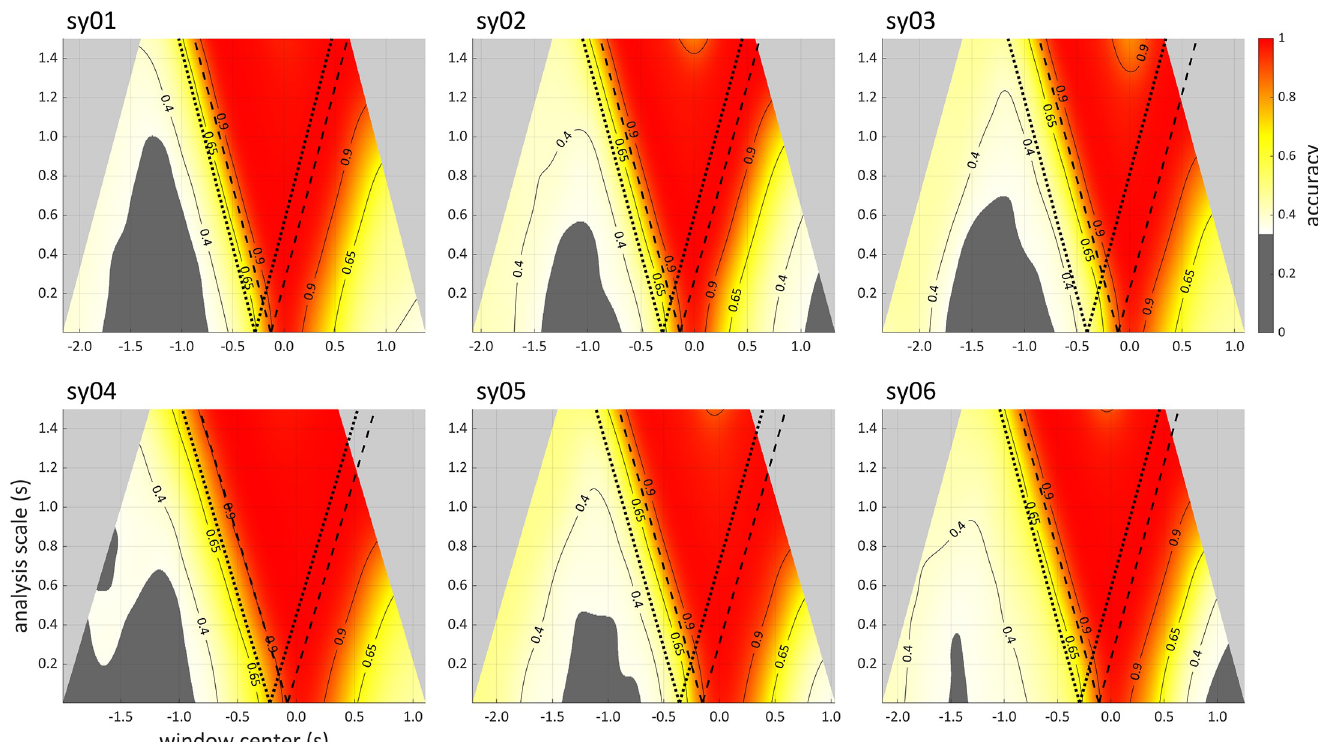
Fig 6. Accuracy scalograms for all six speakers in the syllable production dataset. Scalograms are smoothed and interpolated. Dark gray areas indicate where accuracy is not significantly above chance (1/3). The pairs of dotted and dashed lines in each panel show the centers of windows whose right or left edges align with the 5 th and 95 th percentiles of distributions of onset consonant movement initiation. The dotted lines on the left are associated with windows that end before the time of movement initiation, and the dotted lines on the right are associated with windows that begin at the time of movement initiation.